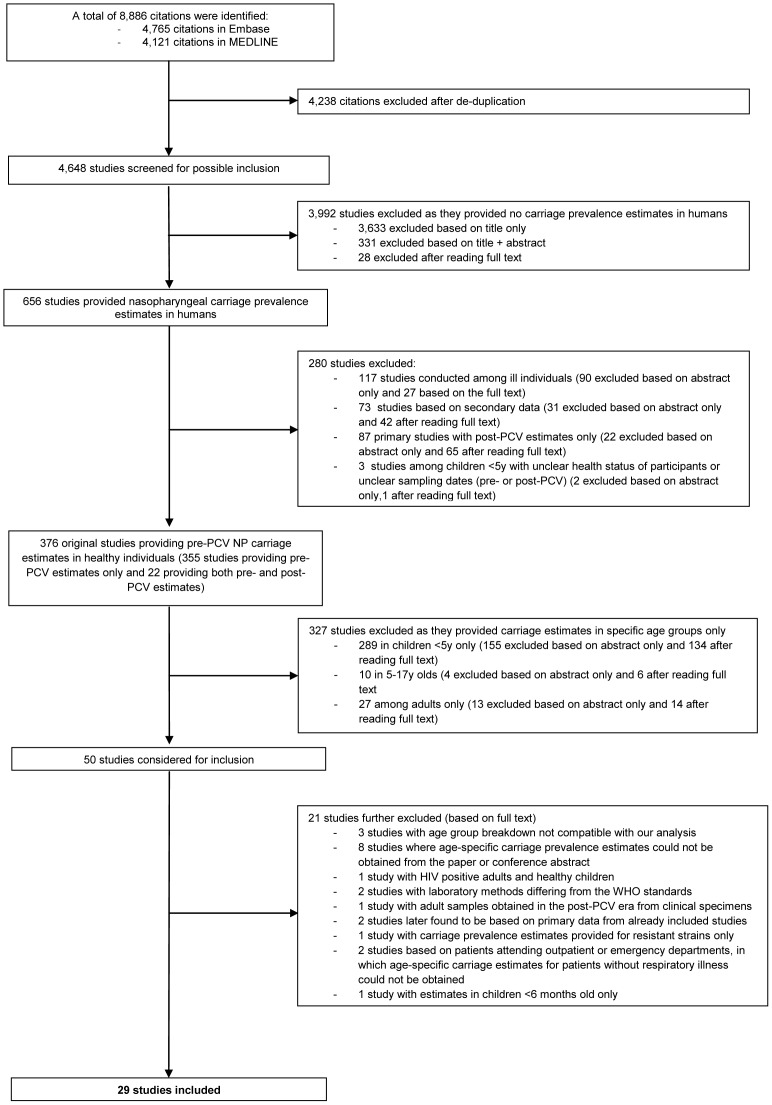
Flow chart of the study selection process.